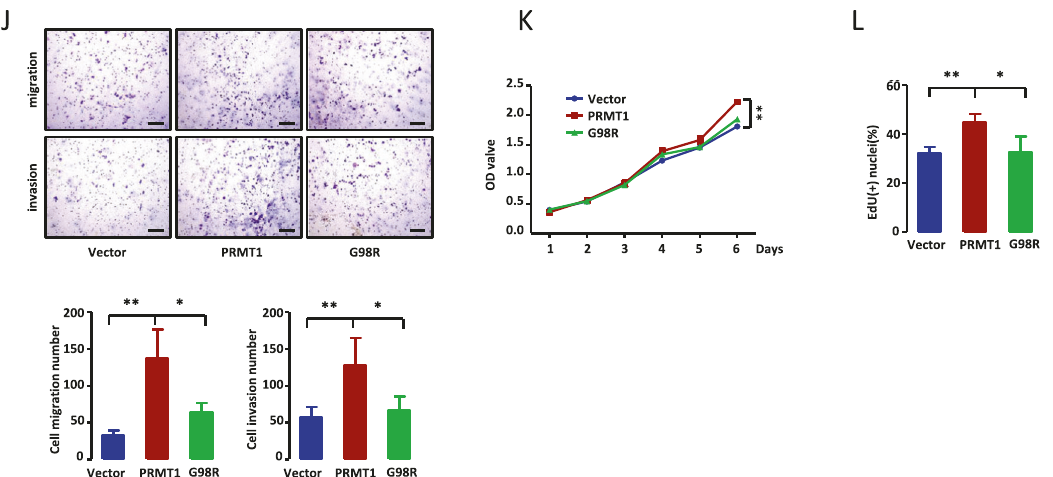
Fig. 4 Pharmacological or enzymatic inhibition of HBP1 methylation suppresses tumor cell metastasis and growth. A – H AMI-1 (Selleckchem, Cat#S7884) and MS023 (MedChemExpress, Cat#HY-19615) suppresses tumor cells metastasis and growth. A , B The protein levels of metastasis-related and proliferation-related markers were measured by western blotting in HeLa and MGC803 cells treated with AMI-1 (10 µM, 24 h) and MS023 (10 µM, 24 h). C , D Transwell assays were performed to test the migratory and invasive potential of the cells above ( n = 5, Student ’ s t -test). Scale bar, 200 µm. E , F MTT ( n = 3) and G , H EdU incorporation assays were performed to test the ability of cell growth in the cells above ( n = 4, Student ’ s t -test). I – L G98R suppresses tumor cells metastasis and growth. I The protein levels of metastasis-related and proliferation-related markers were measured by western blotting in HeLa and MGC803 cells transfected with empty vector, PRMT1 or G98R. J Transwell assays were performed to test the migratory and invasive potential of the cells above ( n = 4, one-way ANOVA). Scale bar, 200 µm. K MTT ( n = 3, one-way ANOVA) and L EdU incorporation assays were performed to test the ability of cell growth in the cells above ( n = 4, one-way ANOVA). Date were the mean ± SD. * p < 0.05, ** p <